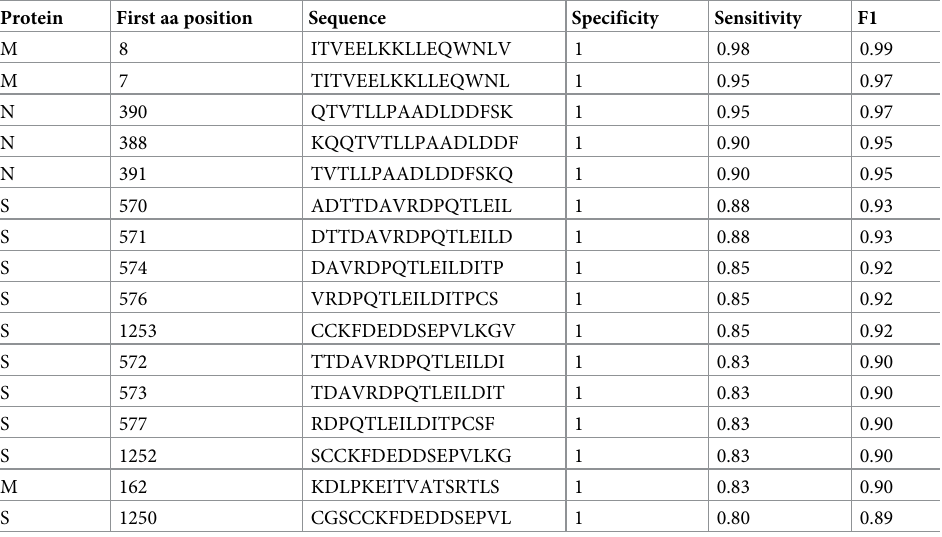
typically determined by evaluating a pure preparation of specific antibodies or by competition assays. However, since our Wisconsin controls are almost certainly na ï ve to MERS-CoV, SARS-CoV, and bat and pangolin CoVs, we can make predictions about cross-reactivity (as opposed to binding due to sequence identity). Table 2. Sixteen peptides in the SARS-CoV-2 proteome had 100% specificity and at least 80% sensitivity for SARS-CoV-2 infection in 40 COVID-19 convalescent patients compared to 20 na ï ve controls. Protein First aa position